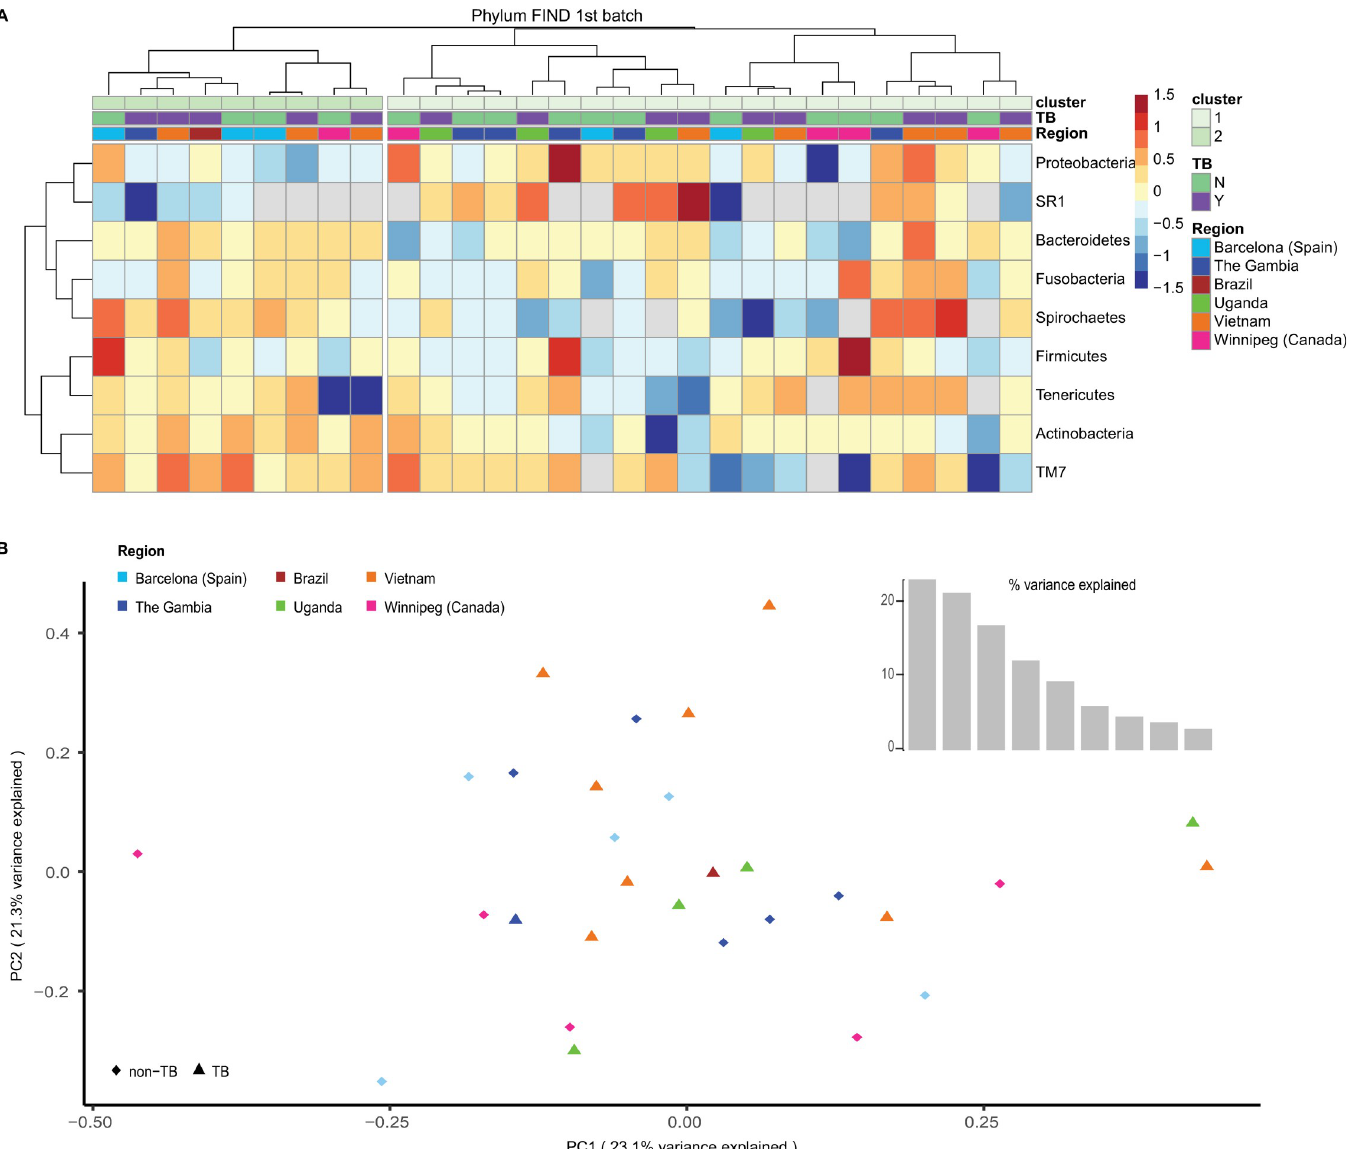
Fig 1. Analysis of the first batch of samples received from FIND. A. Heatmap of Phylum abundances across samples. Hierarchical clustering did not segregate the data according to disease (TB in violet, non-TB in green) nor to the region of origin. B. PCoA (PC1 vs. PC2) displaying all of the samples, colored according to the country. The different shapes (triangle or circle) indicate TB and non-TB samples, respectively. No segregation could be observed. The percentage of variance explained for the first components is shown in the